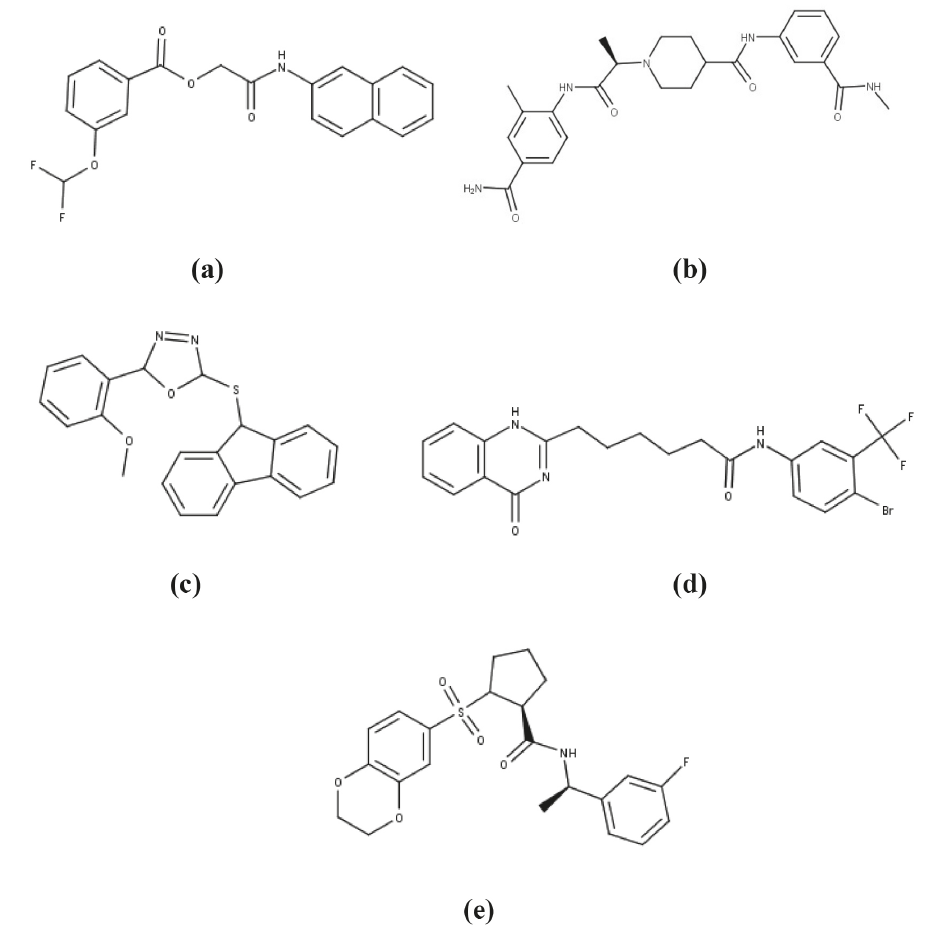
FIGURE 30 - Chemical structures of lead compounds: ( a ) S-258002927; ( b ) S-258012947; ( c ) S-258282355; ( d ) S-259411474; ( e ) S-259417539.